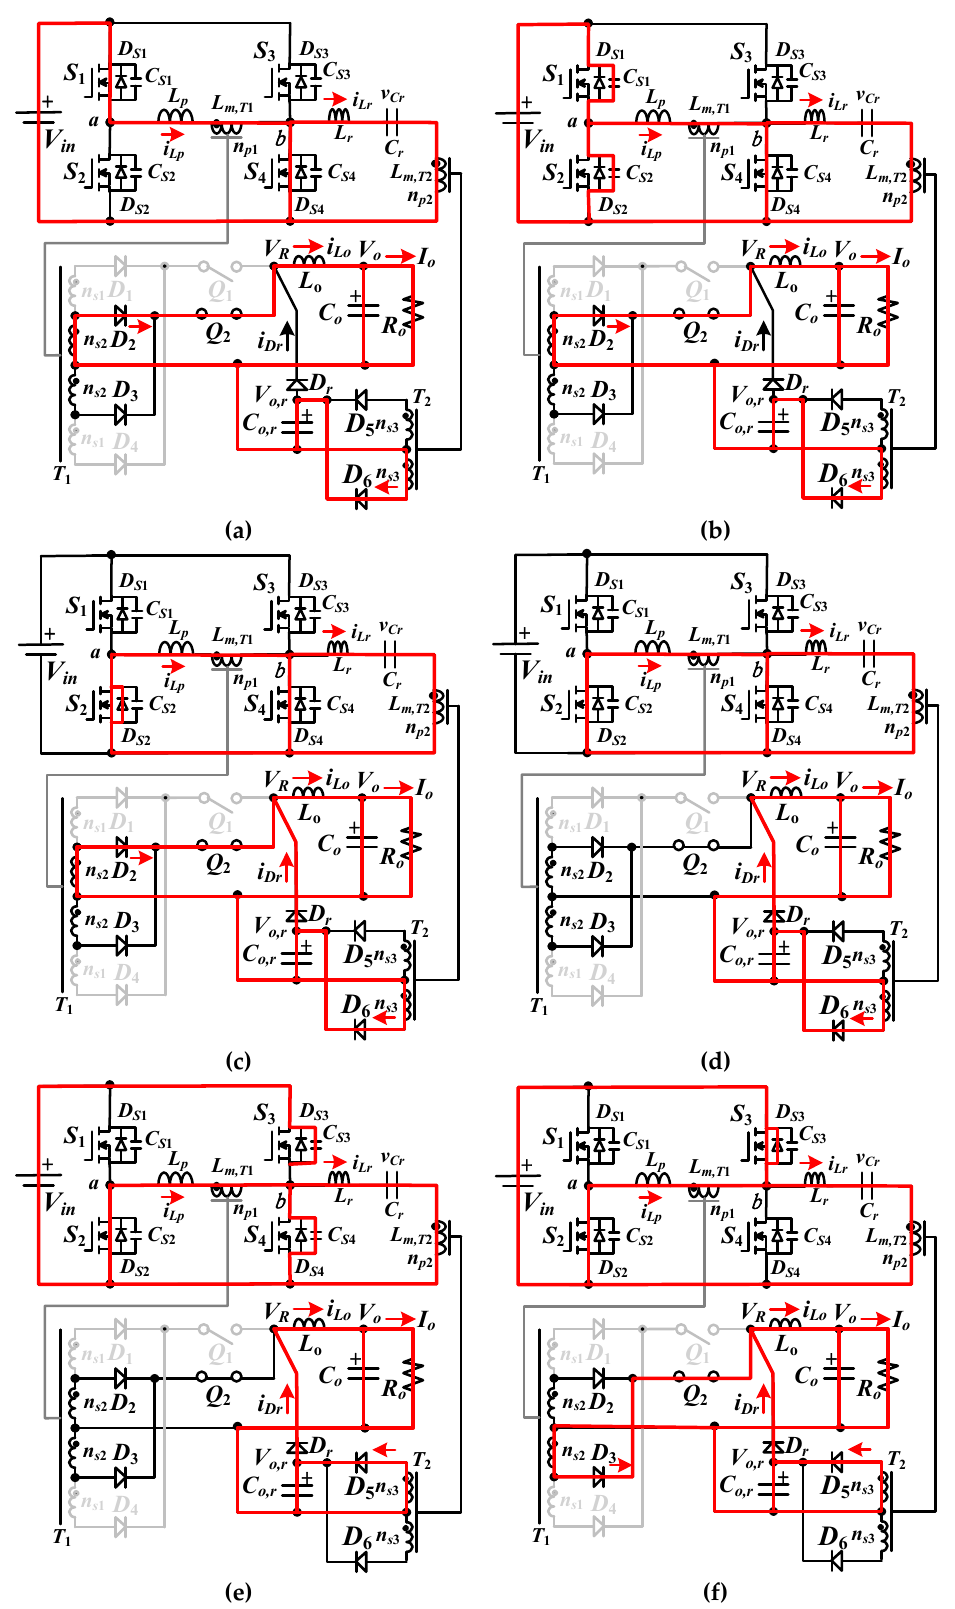
Figure 4. State circuits of the first half switching cycle under high voltage input operation ( a ) state 1 circuit ( a ) state 1 ( b ) state 2 ( c ) state 3 ( d ) state 4 ( e ) state 5 ( f ) state 6.